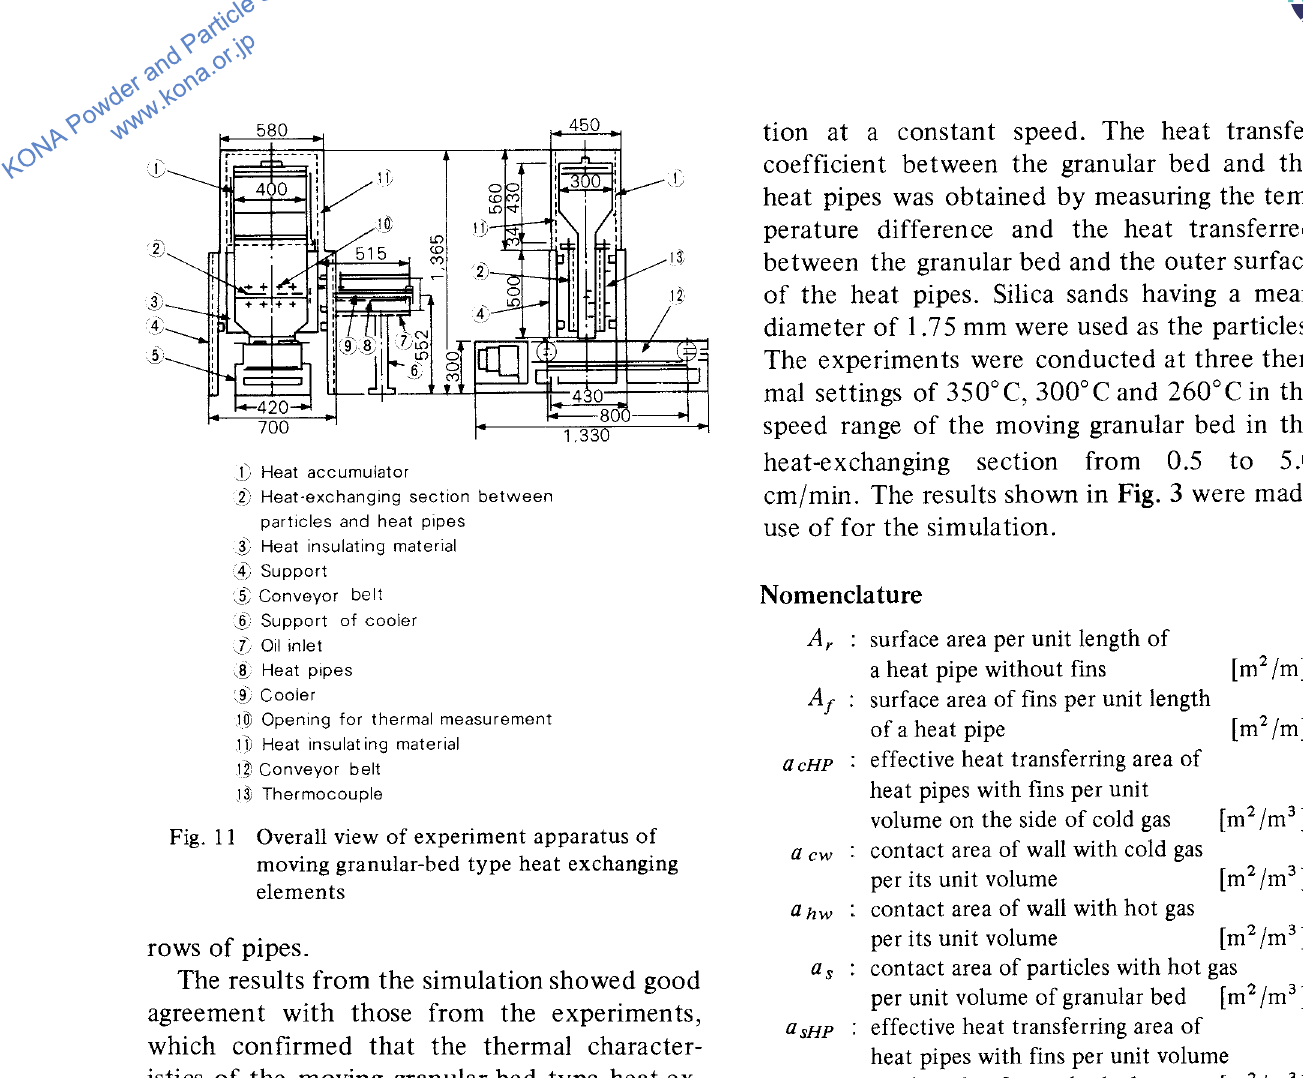
Fig. 11 Overall view of experiment apparatus of moving granular-bed type heat exchanging elements rows of